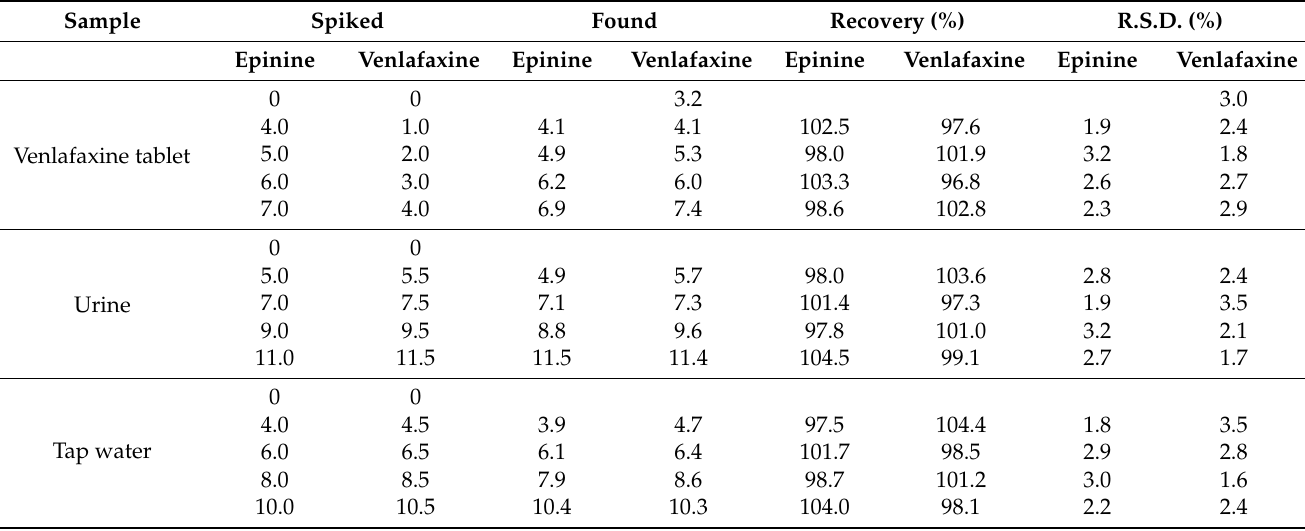
Table 1. Determination of epinine and venlafaxine drugs in real samples using NiCo-MOF/SPGE. All concentrations are in µ M. (n =